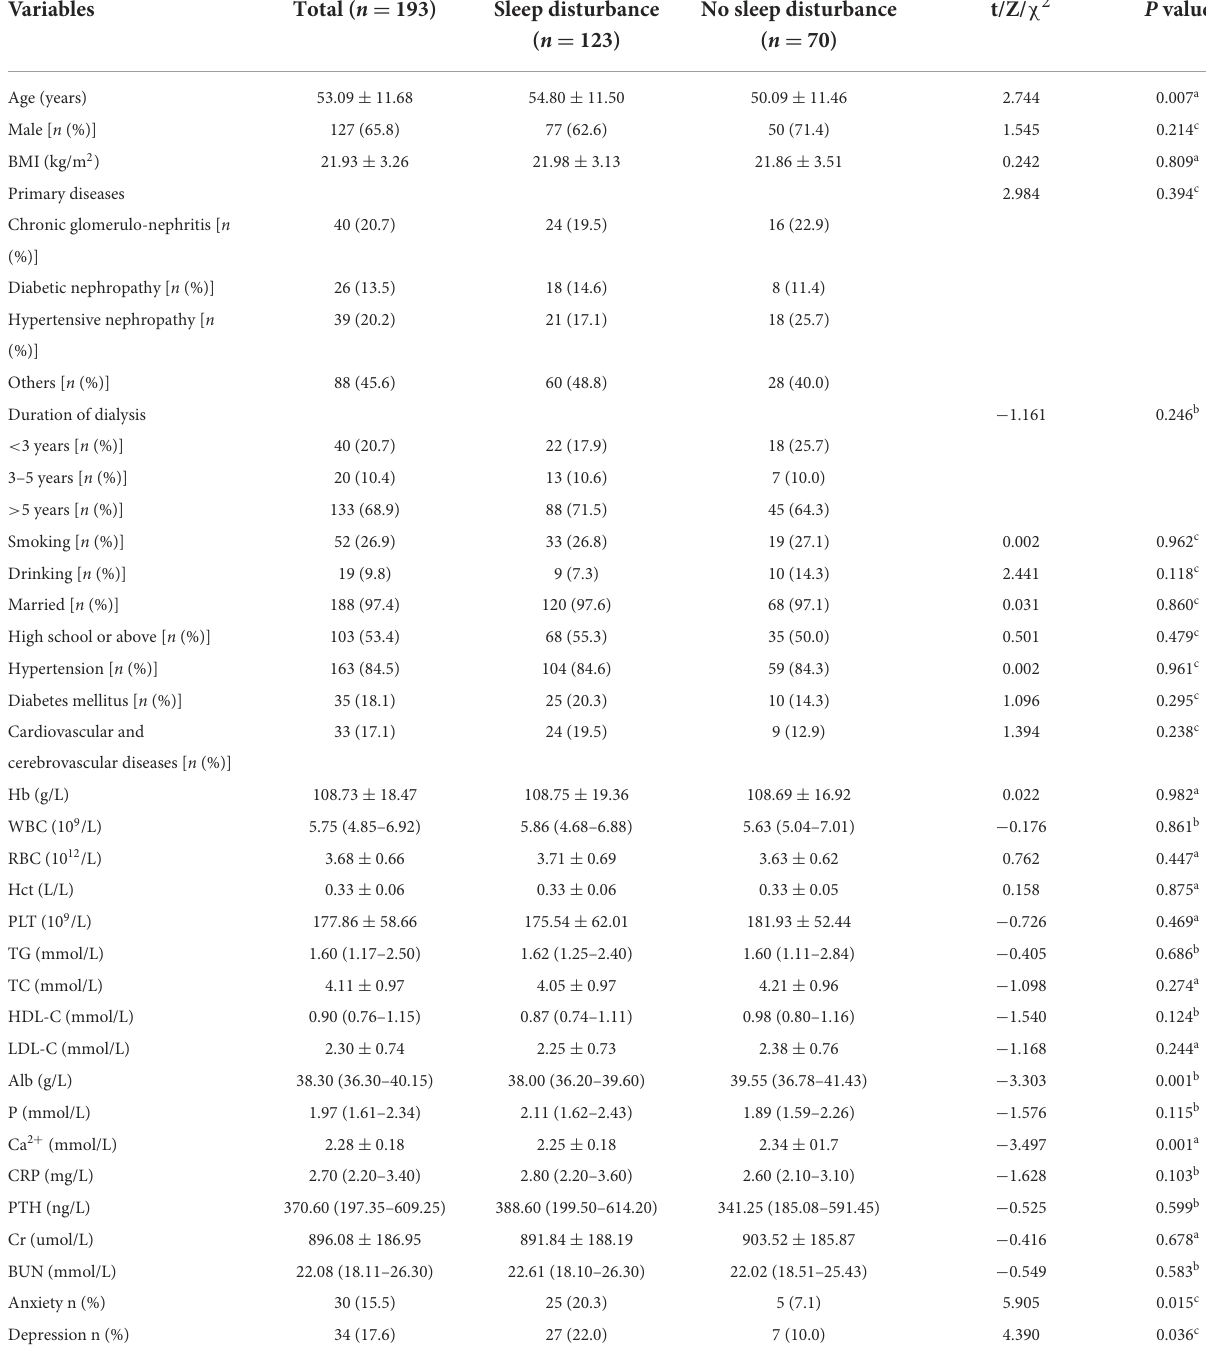
TABLE 1 Clinical characteristics of MHD patients with or without sleep